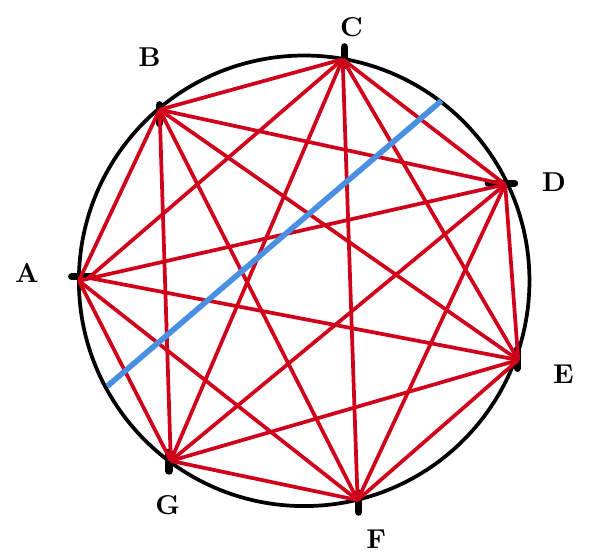
Figure 8 . The bulkless graph for N = 7 vertices. We can think of the vertices as ordered around a circle and connected by all possible chords. Cuts are given by chords that separate the boundary vertices in a contiguous region R from those in its complement [ N ] − R : for example, the blue chord is a cut between ABC and DEFG